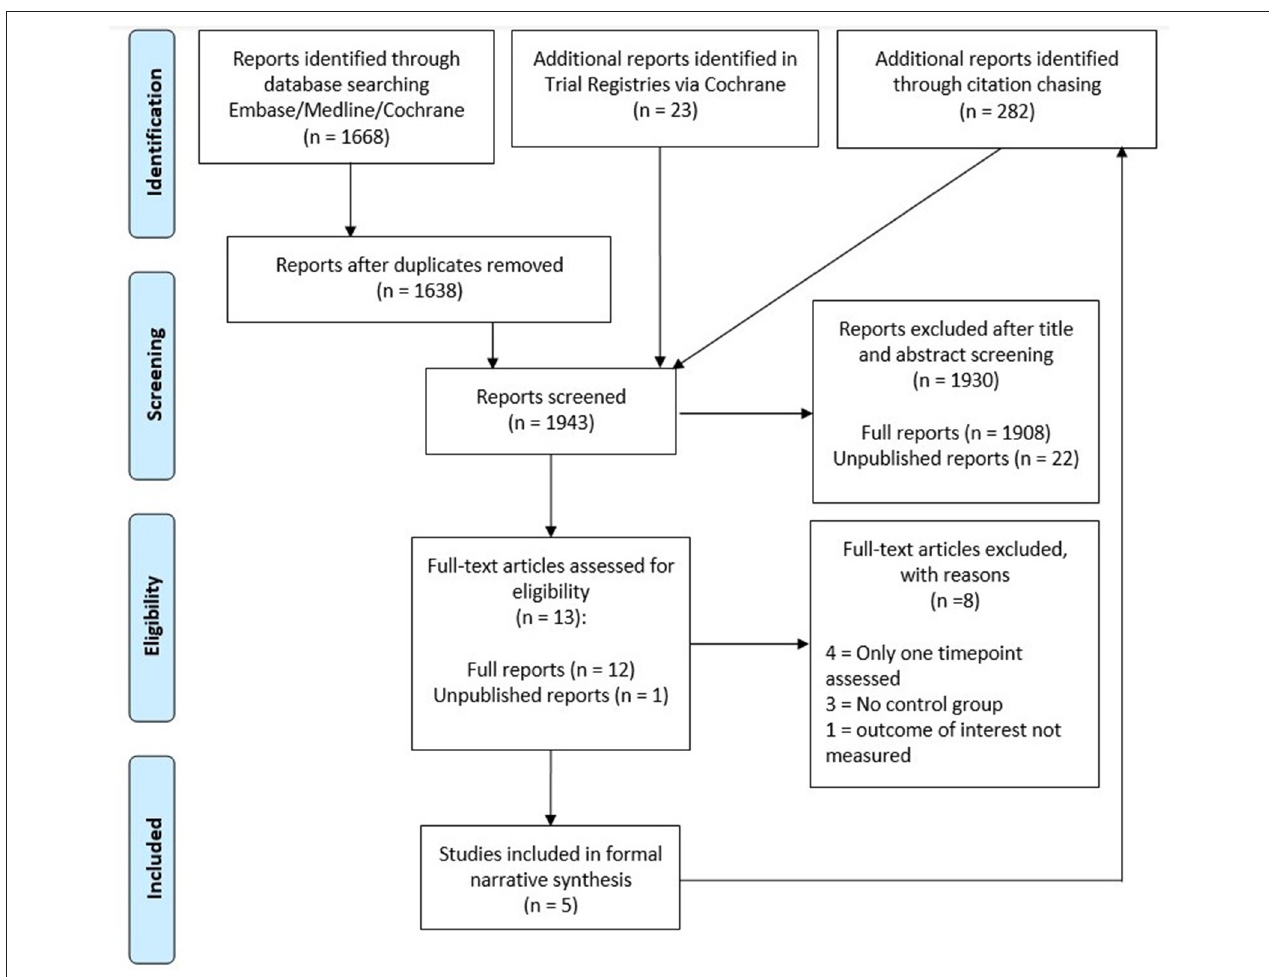
FIGURE 2 | Prisma flow diagram detailing search results and screening